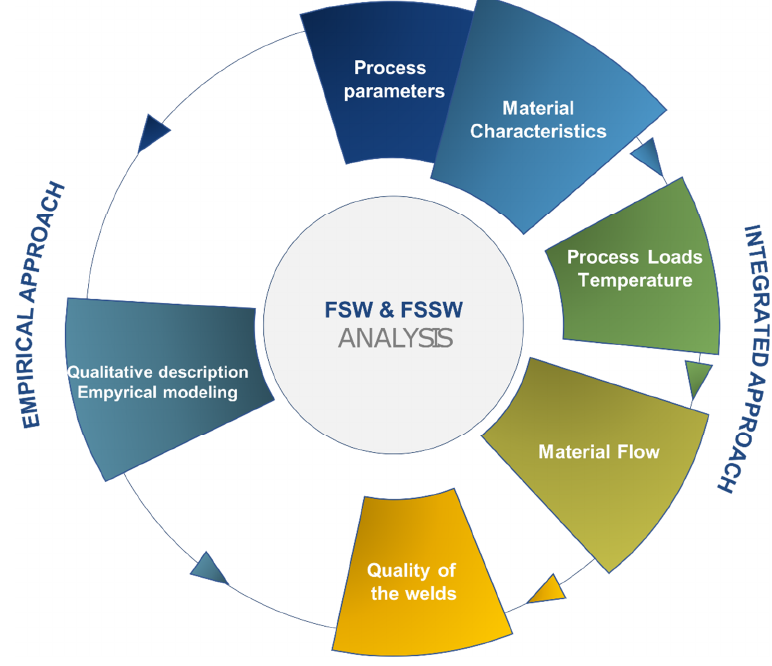
Figure 38. Comparison between empirical modeling approach vs. integrated approach.